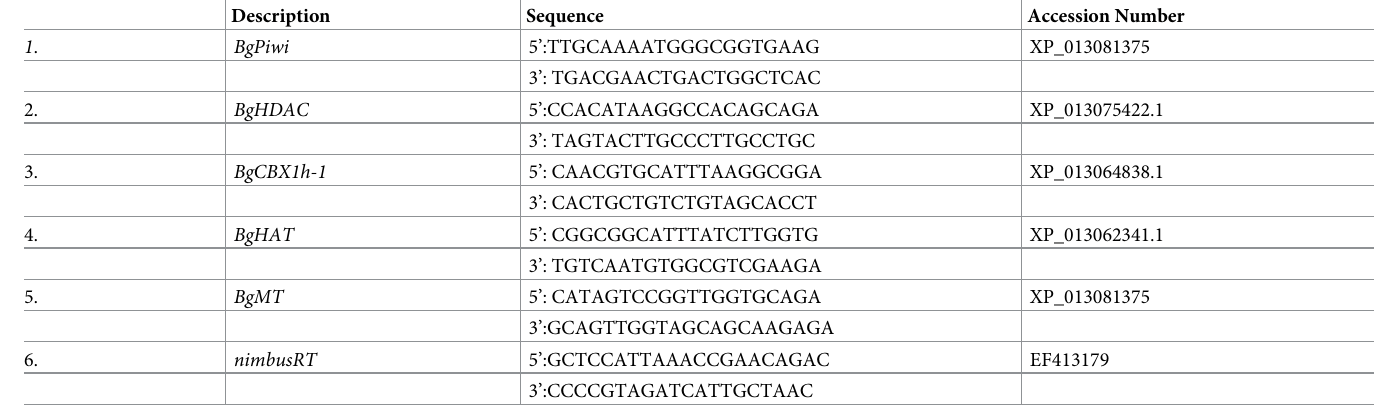
Table 2. Selected transcripts, accession numbers, and corresponding F and R primers utilized for qPCR.